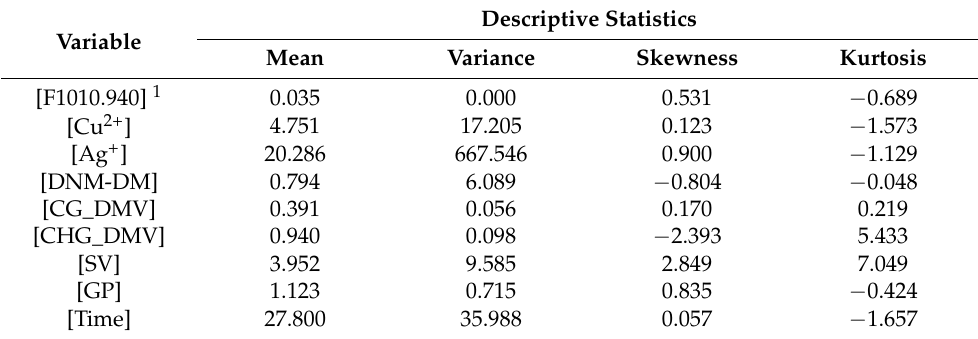
Table 1. Descriptive statistics of the analyzed variables and their presence in postulated models (calculated based on data in Table